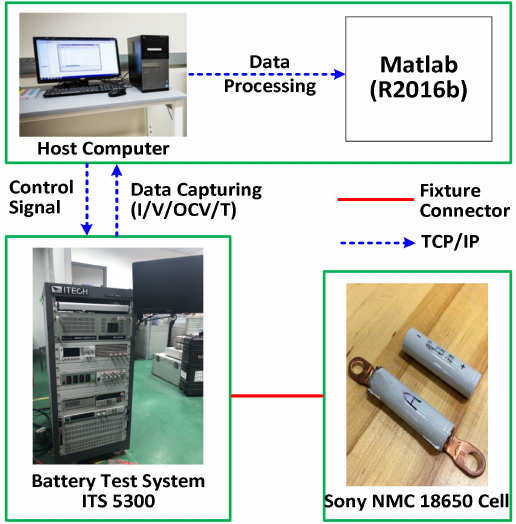
Figure 2. Schematic of battery experimental setup.